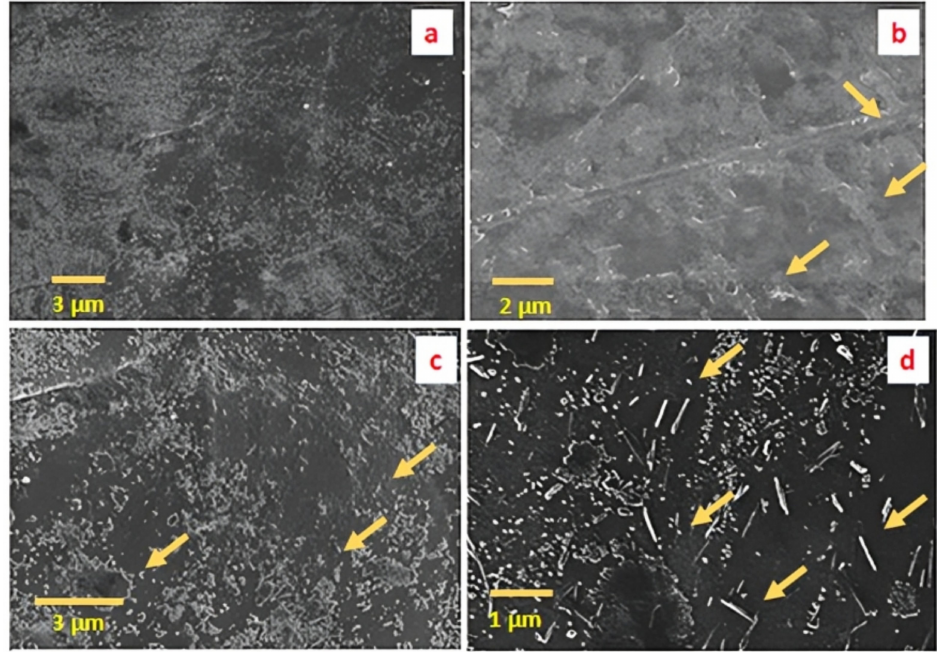
Figure 5. SEM images of S0 (pristine PS) in ( a ), S1 (PS/1 wt.% sepiolite) in ( b ), S2 (PS/2 wt.% sepiolite) in ( c ) and S4 (PS/4 wt.% sepiolite) in ( d ).